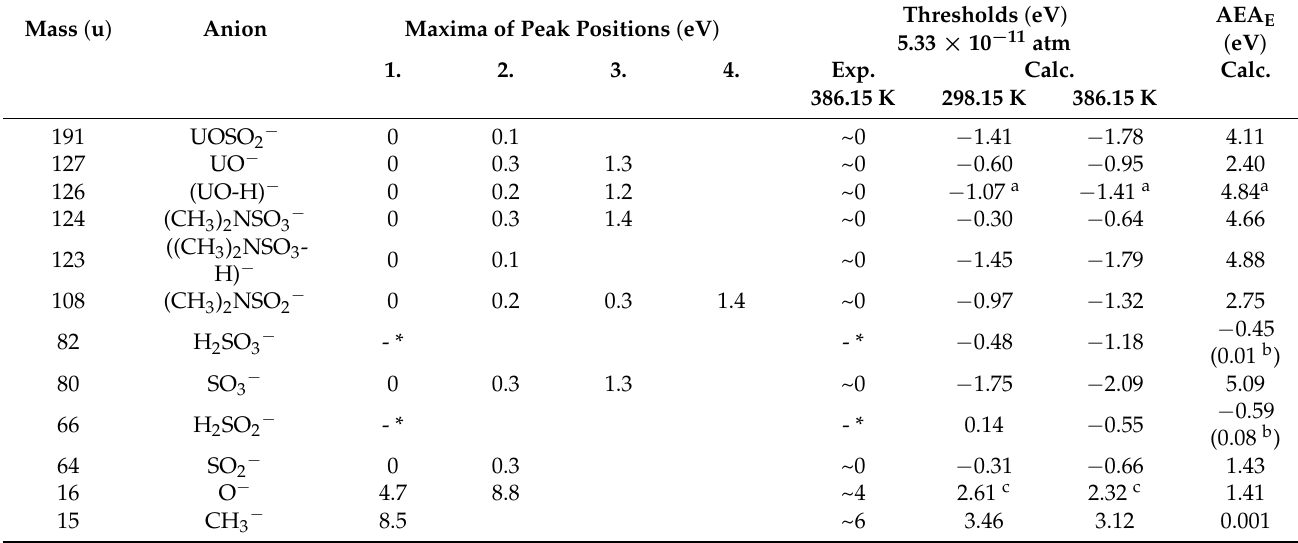
* Experimentally not detected but investigated by computational methods. a For N1-H site; alternative site N3-H thresholds: − 0.43/ − 0.78 eV at 298.15/386.15 K. b the G2MP2 [27] method of chemical accuracy was used for calculation of AEA E for H 2 SO 3 and H 2 SO 2 . c For O12 site; alternative sites O7: 4.86/4.57 eV, O8: 5.12/4.83 eV, O11: 2.76/2.45 eV at 298.15K/386.15K. d Corresponds to NH − (see text).